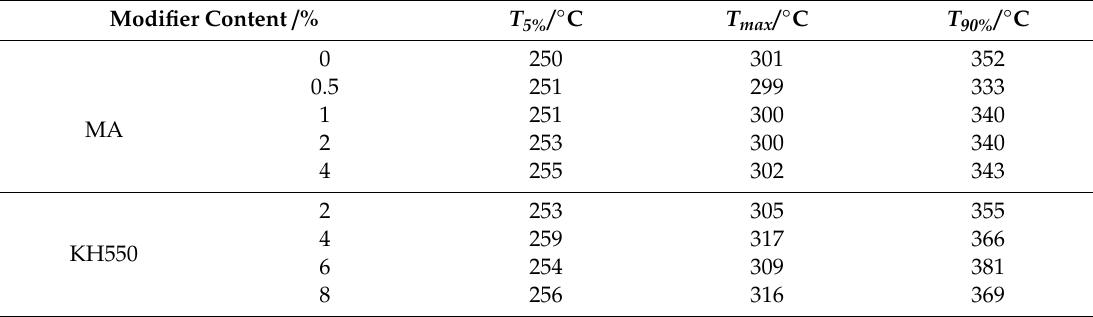
Table 1. Temperatures of initial ( T 5% ), peak ( T max ) and end ( T 90% ) degradation of MA-